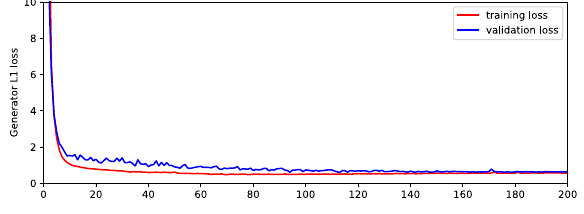
Figure 4. The plot of training and validation losses for training